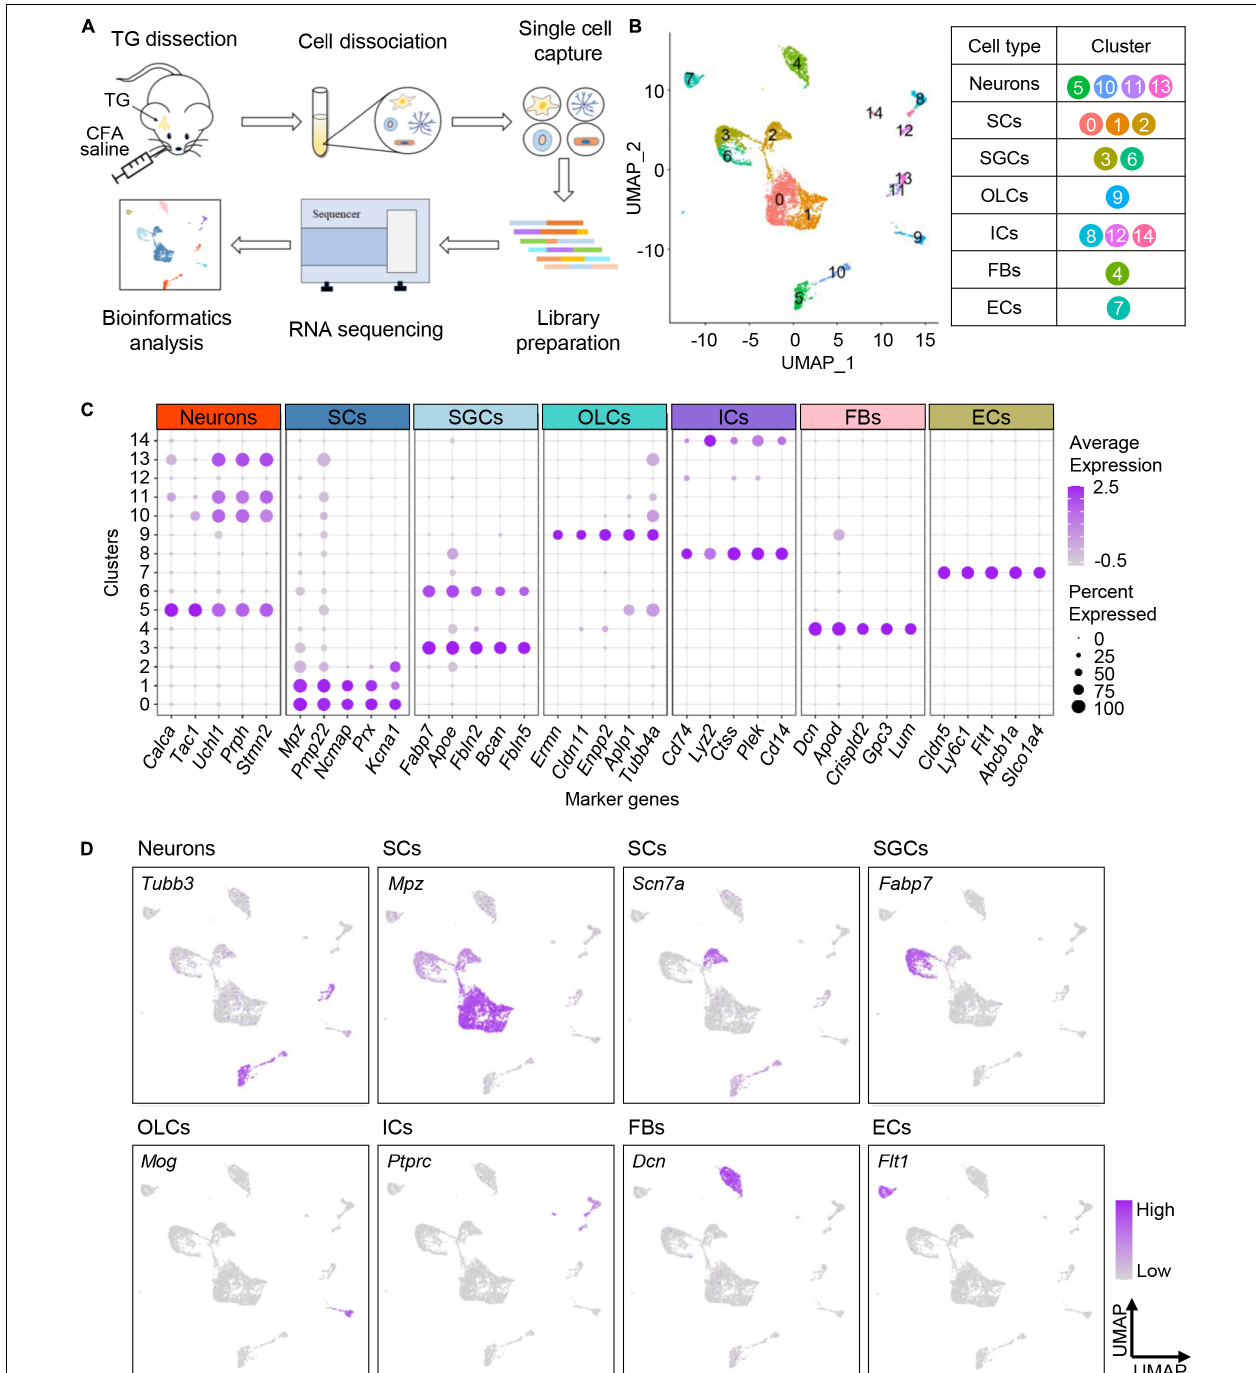
FIGURE 2 | Profiling cell types in mouse TG by scRNA-seq. (A) Schematic diagram of experimental design. TGs are dissociated 7 days after CFA/saline injection, and the obtained cell suspensions are further processed with BD Rhapsody scRNA-seq. (B) UMAP plot of all cells in TGs obtained from normal and experimental groups. The identified 15 clusters are colored and annotated based on known marker genes from previous studies. (C) Dot plot of the top five marker genes for each cell type. Dot color intensity represents the average expression level, and dot size represents the percent of cells expressing the gene. (D) UMAP plots of expression pattern of marker genes that best identify each cell type. Marker genes: Tubb3 (neurons), Mpz (myelinating Schwann cells), Scn7a (non-myelinating Schwann cells), Fabp7 (satellite glial cells), Mog (oligodendrocyte-like cells), Ptprc (immune cells), Dcn (fibroblasts), and Flt1 (endothelial cells). The color intensity represents the expression level. scRNA-seq, single-cell RNA-sequencing; TG, trigeminal ganglion; CFA, complete Freund’s adjuvant; UMAP, uniform manifold approximation and projection; SCs, Schwann cells; SGCs, satellite glial cells; OLCs, oligodendrocyte-like cells; ICs, immune cells; FBs, fibroblasts; ECs, endothelial cells.